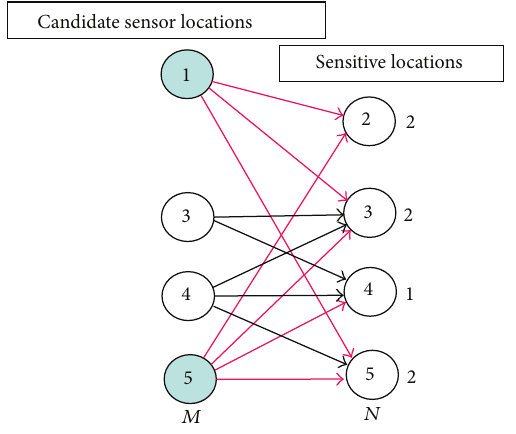
Figure 9: The sensor location